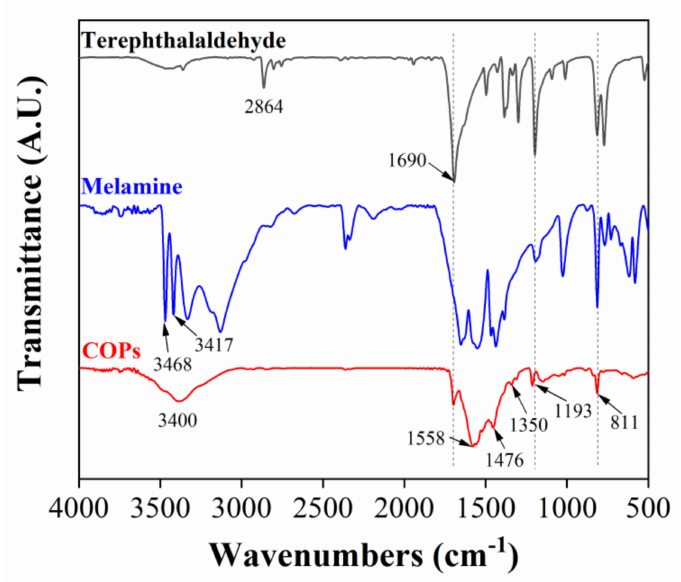
Figure 3. FT-IR spectra of COPs, melamine and